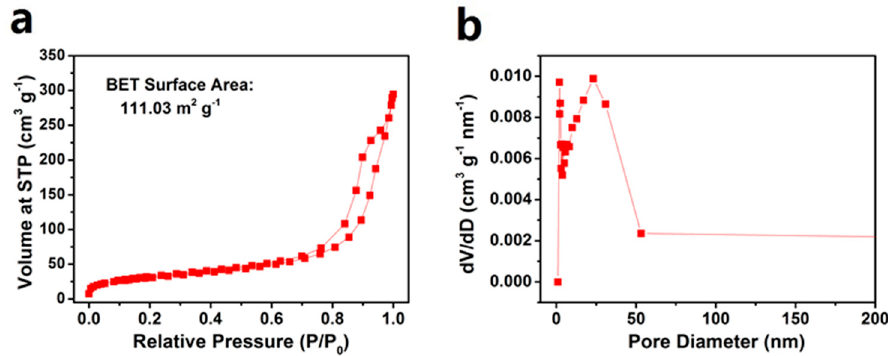
Figure 4. ( a ) N 2 adsorption/desorption isotherms and ( b ) Pore size distribution of the PPS.